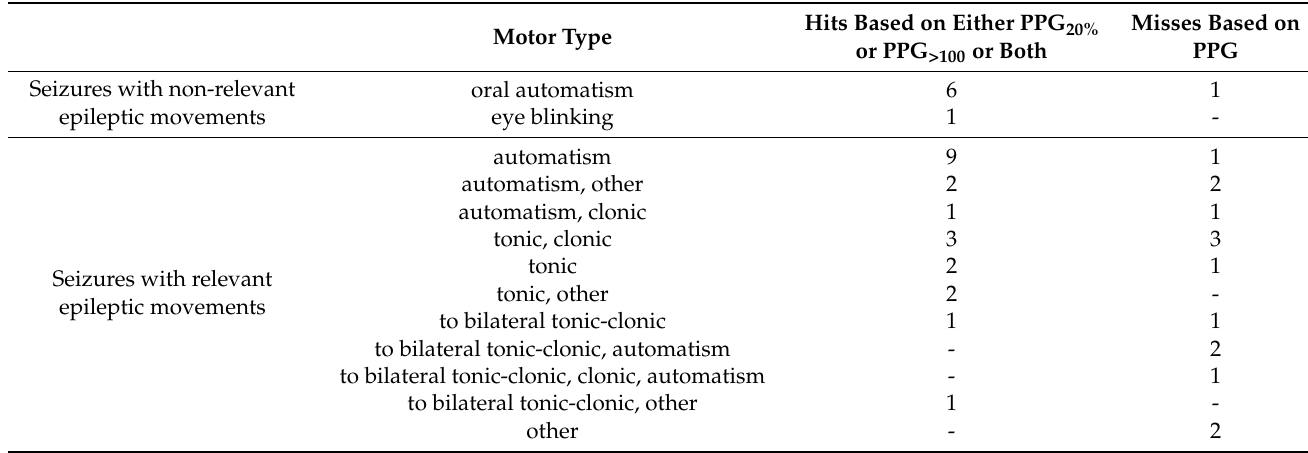
Table A2. Number of identified and non-identified motor seizures and corresponding motor manifestations. Epileptic movements not further classifiable are referred to as